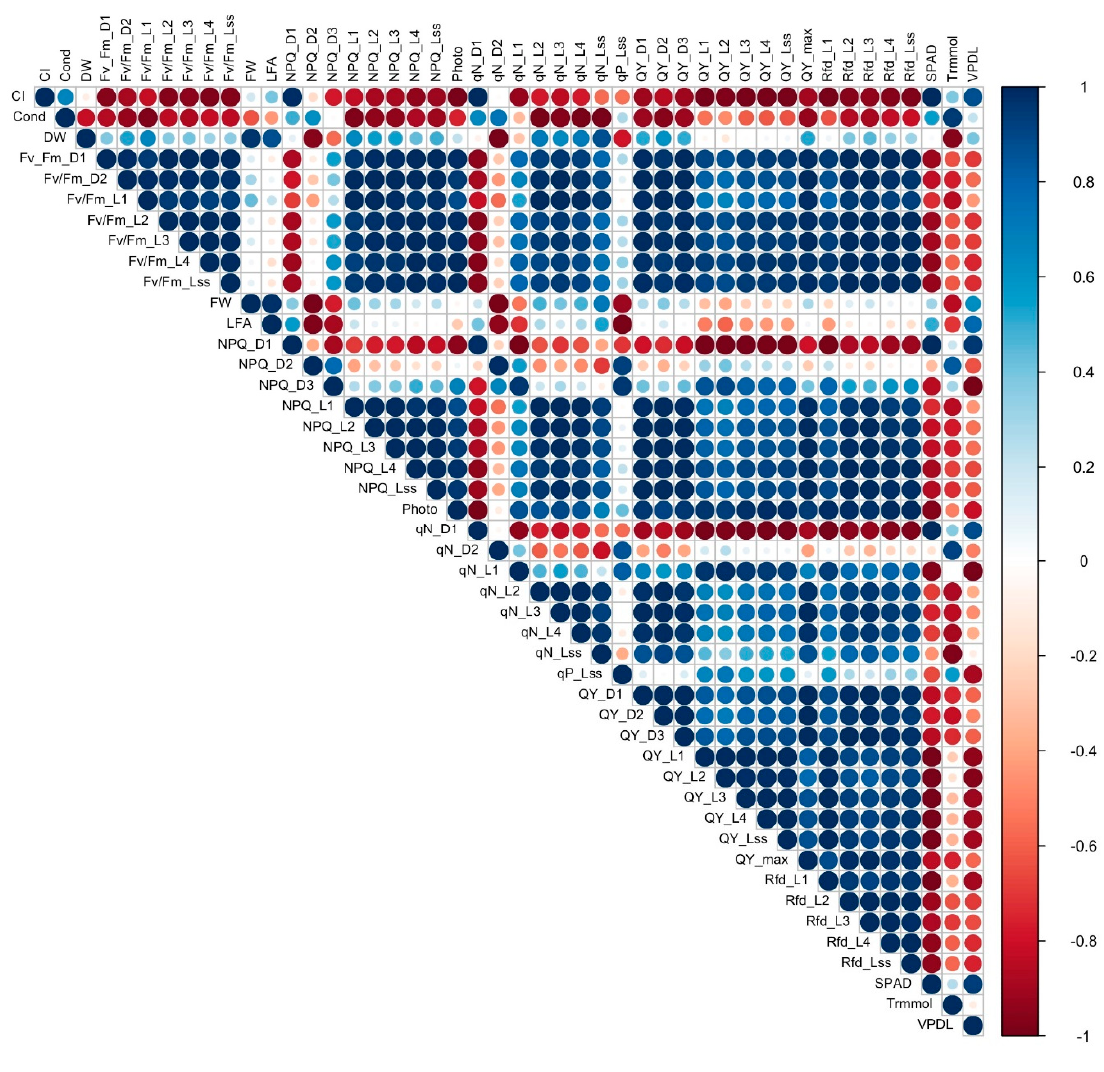
Figure 8. Graphical representation of a correlation matrix of morphological, physiological, and chlorophyll fluorescence parameters between tolerant genotypes PI 253468, PI 171676a, and “Mayfair”, highlighting the most correlated variables. Blue color represents positive correlation whereas red represents negative correlation. Color intensity and size of the circle are proportional to the correlation coefficients which are depicted in the legend to the right.